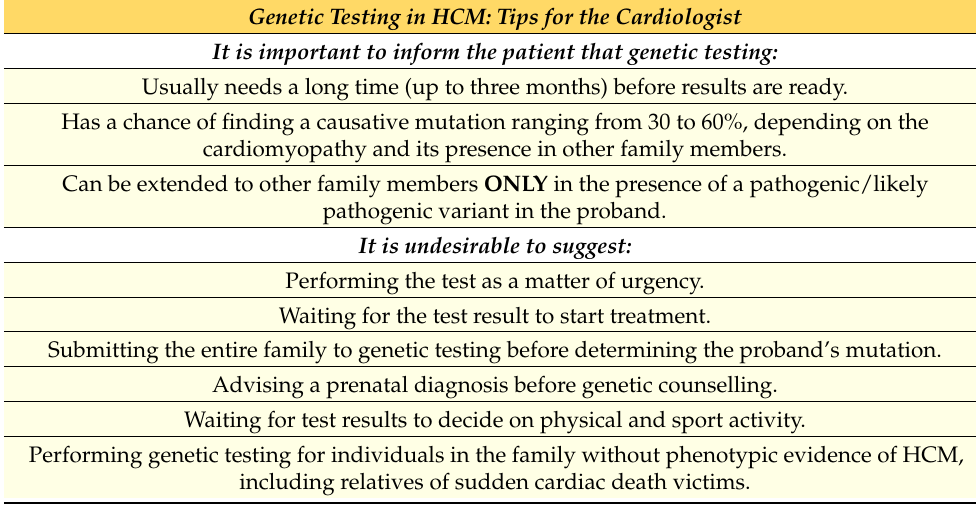
Table 1. Recommendations for the cardiologist on genetic testing in HCM. Genetic Testing in HCM: Tips for the